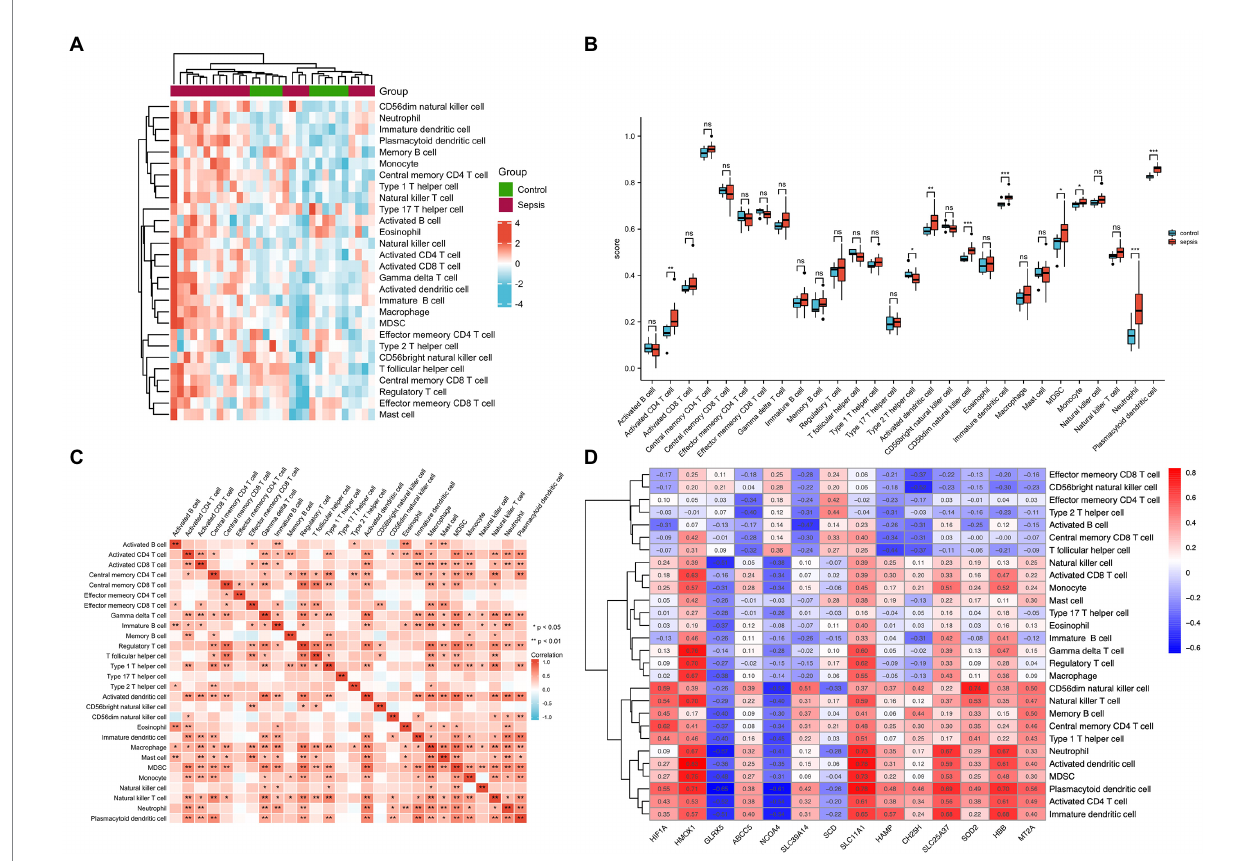
FIGURE 4 Landscape of immune infiltration in the myocardium of patients with sepsis and controls. (A) Heatmap of the proportions of the 28 immune cell types. (B) Box plots of immune cell proportions. (C) Correlation analysis of immune cells. (D) Correlation between common differentially expressed IMRGs and immune